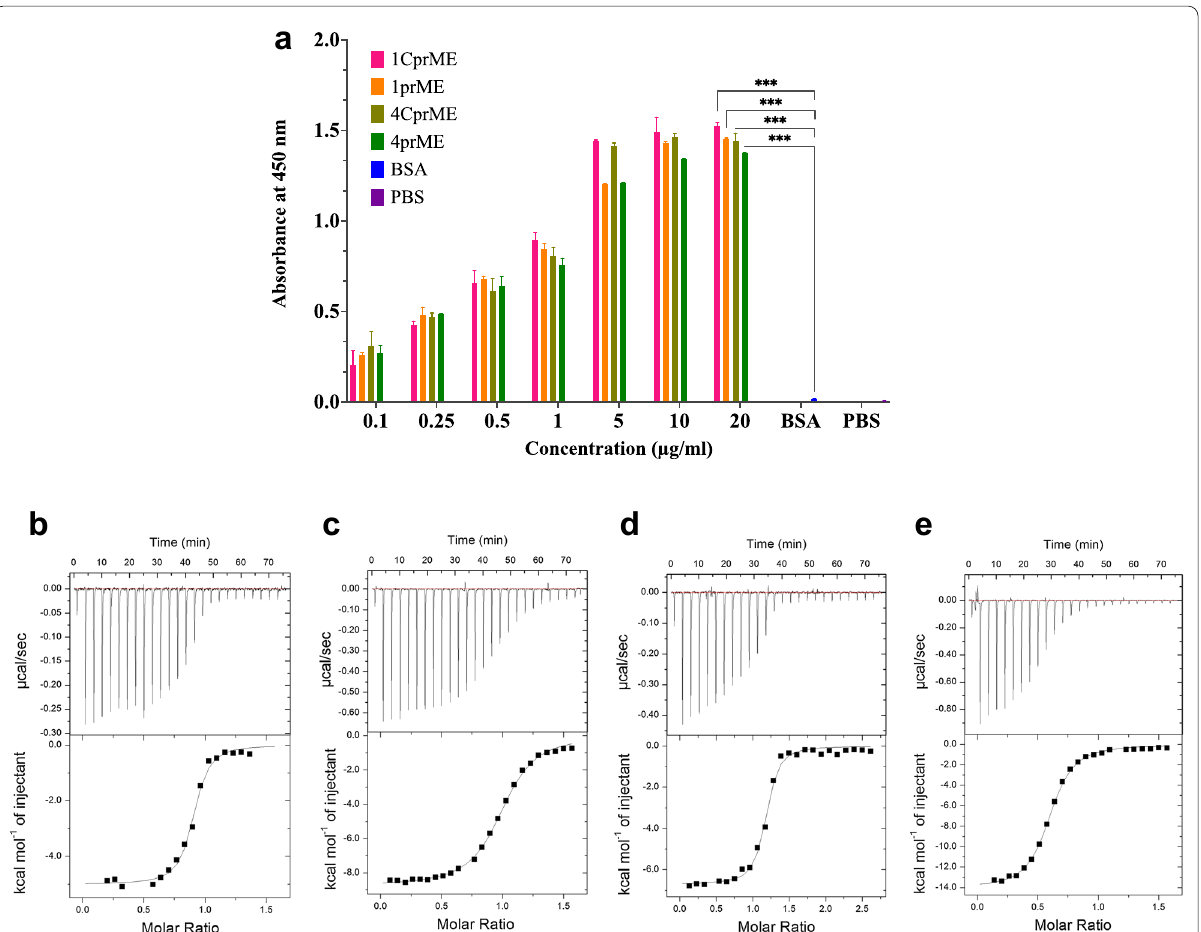
Fig. 5 a Binding assay of DENV-LPs/1CprME, /1prME, /4CprME, and /4prME to heparin using ELISA. Heparin (1.8 ng) was coated onto each well of an ELISA plate, and each amount of purified protein was used for this ELISA, which was carried out according to the protocol described in the Materials and methods (Welch t-test, *p < 0.05, **p < 0.01, ***p < 0.001). b – e The binding activities between DENV-LPs/1CprME, /1prME,